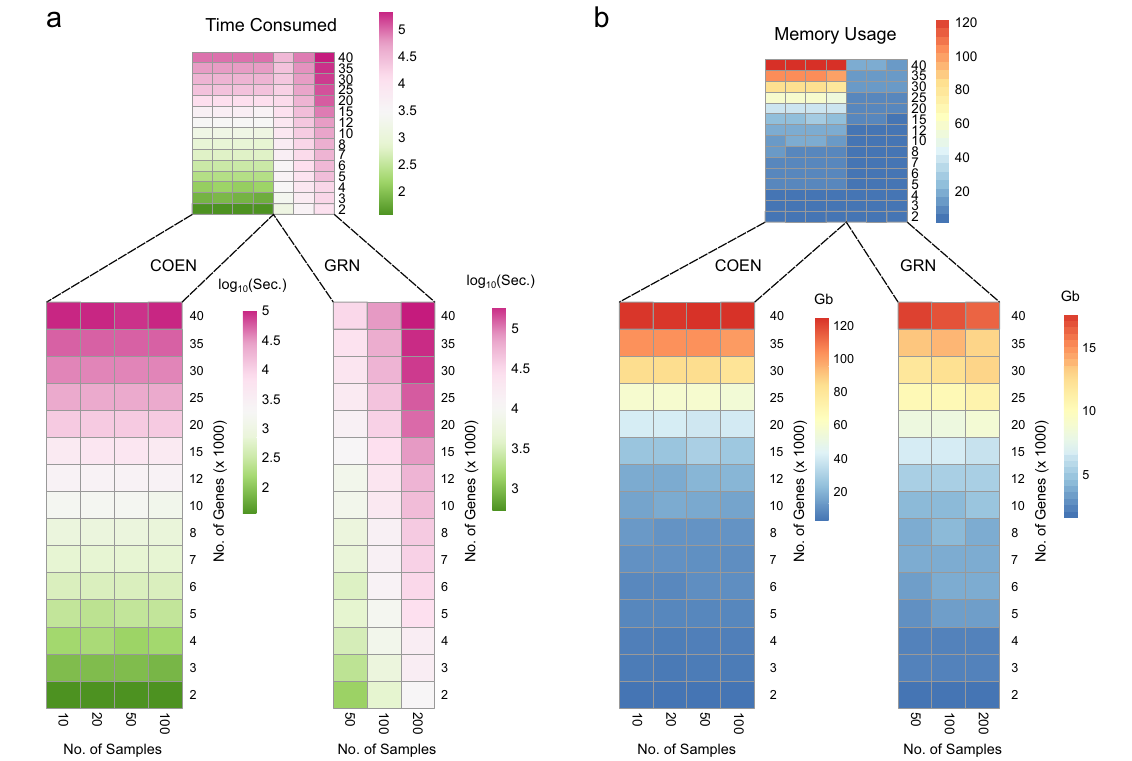
Fig. 2 Time consumption and memory usage by RegEnrich . With one CPU core, ( a ) the time consumed and ( b ) maximum memory used by RegEnrich when analyzing a gene expression dataset with different numbers of genes (ranging from 2000 to 40,000) and different numbers of samples (ranging from 10 to 100 and from 50 to 200 for COEN and GRN network,